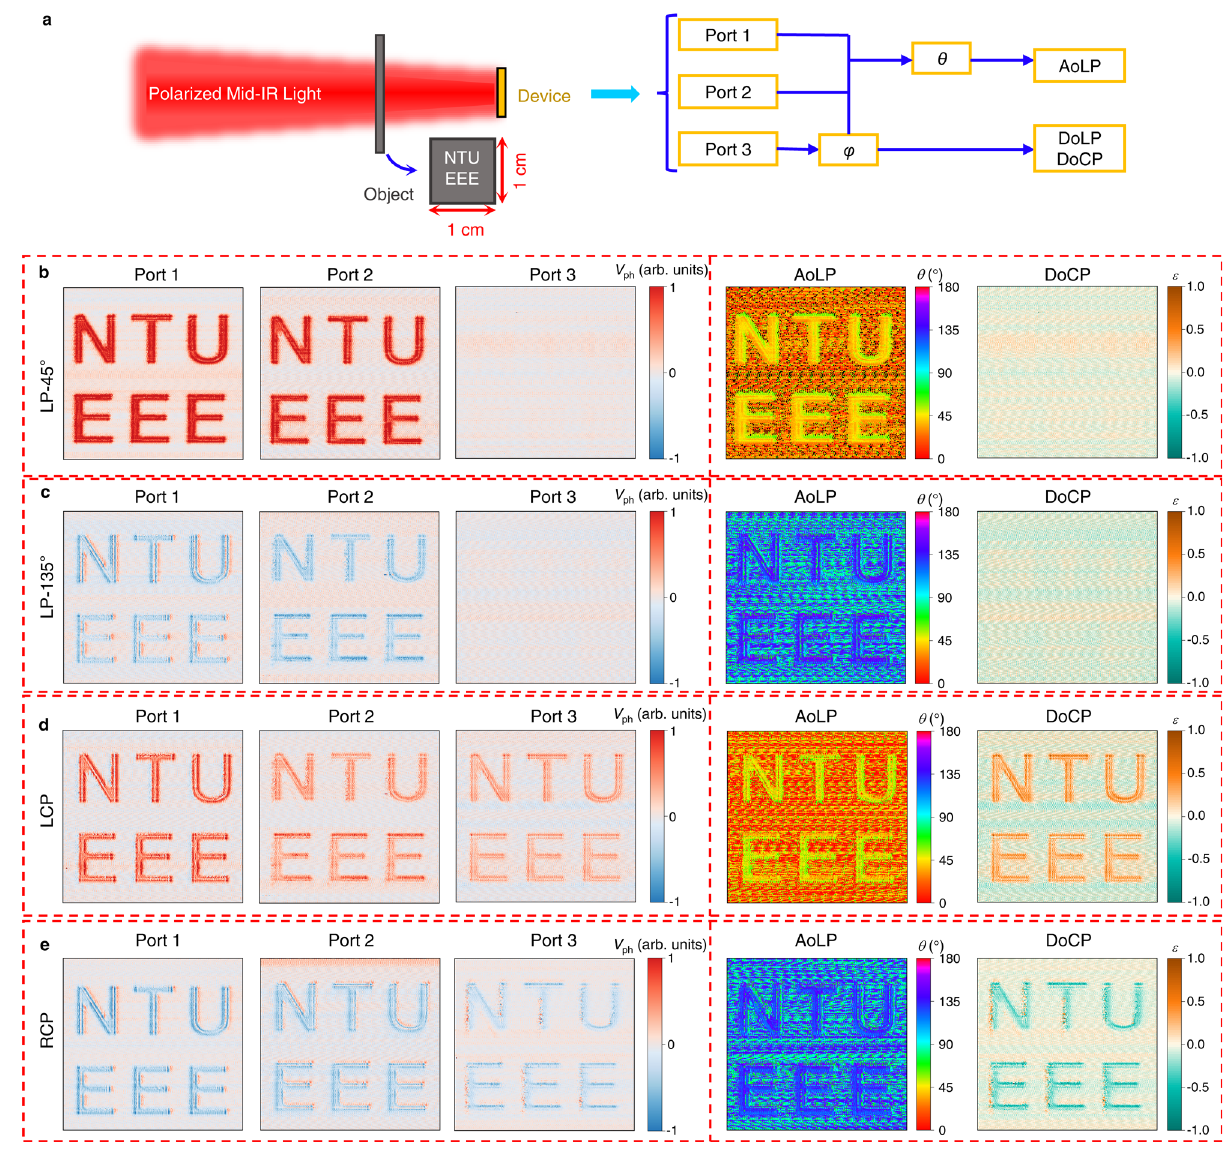
Fig. 5 | Polarimetric imaging applications of the three-ports device. a ,Schematicofthepolarimetricimagingmeasurementsystemandthemechanism for the calculation of angle of linear polarization (AoLP), degree of linear polar- ization(DoLP)ordegree of circularpolarization (DoCP).The inset is the schematic